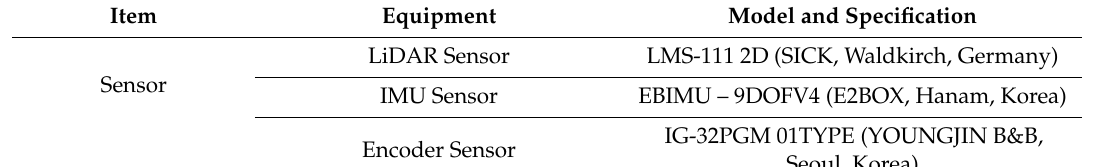
Table 1. Specification of sensors, controller, and driving platform used in this study.